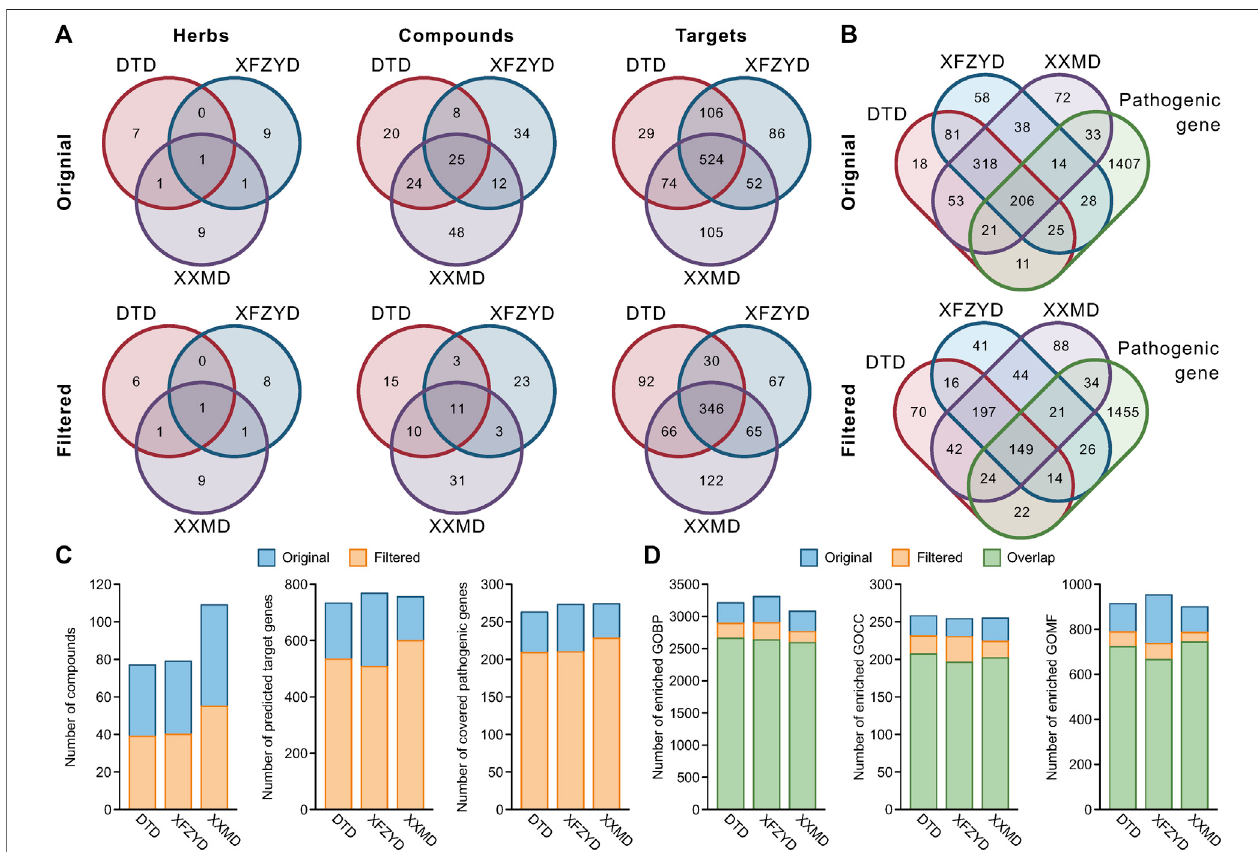
FIGURE 3 | The components and biological functions of the original and fi ltered compound-target (C-T) networks: Venn diagram of herbs, compounds and predicted targets in the original and fi ltered C-T networks of DTD, XFZYD, and XXMD (A) . Venn diagram of predicted targets and pathological genes in the original and fi ltered C-T network (B) . Number of compounds, predicted target genes, and covered pathological genes in the original and fi ltered C-T networks of DTD, XFZYD, and XXMD (C) .NumberofenrichedGObiologicalprocess(GOBP),GOcellularcomponent(GOCC),andGOmolecularfunction(GOMF)termsintheoriginaland fi ltered target genes of DTD, XFZYD, and XXMD (D)